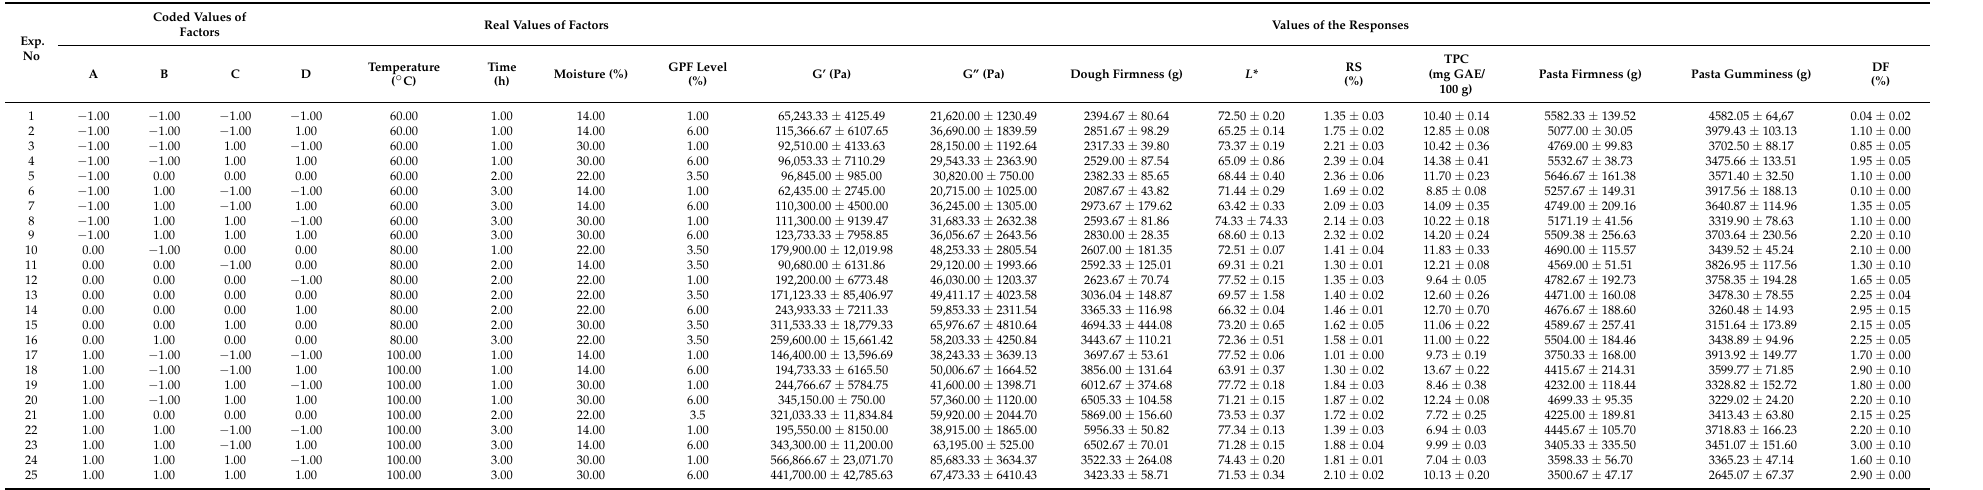
Table 1. Codded vs. real values of the factors and values of the